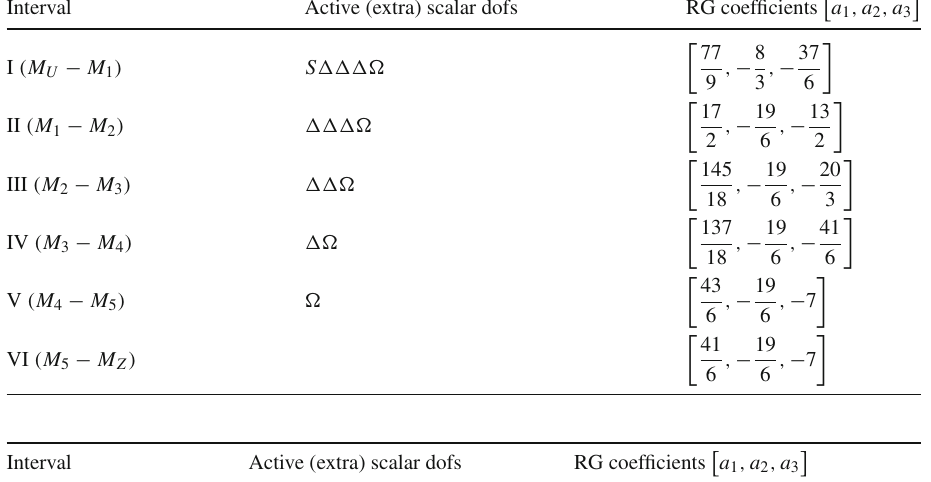
Table 5 The distribution of the new scalars among the